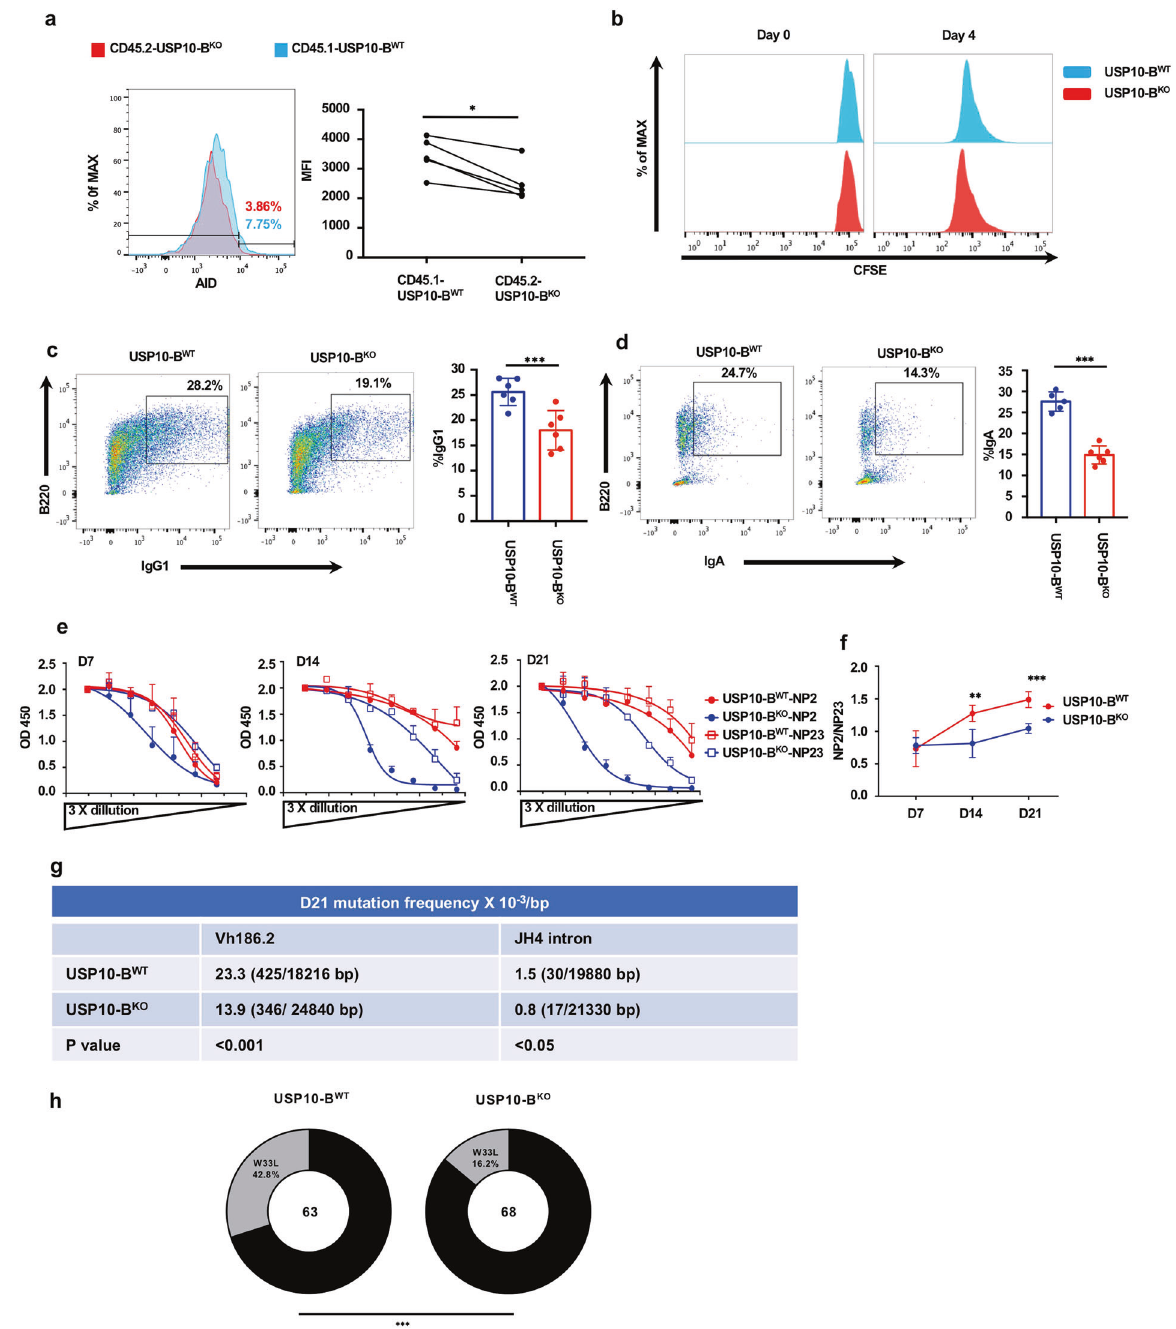
Fig. 3 The mice with USP10 knockout in B cells exhibited a low abundance of AID, impaired class switching, somatic hypermutation, and af fi nity maturation. a Representative fl ow cytometry of AID protein levels in germinal center B cells (B220 + GL7 + CD95 + ) in 50:50 mixed bone marrow (BM) chimera mice using CD45.1-USP10-B WT and CD45.2-USP10-B KO ( n = 5). b Cell proliferation was assessed by staining cells with CFSE. c , d Representative fl ow cytometry of CSR to IgG1 ( C ), IgA ( D ) in splenic naïve B cells in USP10-B WT or USP10-B KO mice. e – g USP10-B WT or USP10-B KO mice were immunized with NP-CGG and analyzed at the time indicated. e , f NP2 and NP23 binding antibodies (total Ig) in sera of immunized mice were analyzed by ELISA. e OD values versus dilution factors are plotted. f Ratios of NP2/NP23 were calculated with raw OD value in a linear range. g The sorted GC B cells pooled from four mice of each genotype were used for the genomic DNA extraction and sequencing of the VH186.2 exon and JH4 intronic region. The total mutation frequencies are shown. The statistical analysis was performed with Fisher ’ s exact test. h The frequency of W33L mutation in the VH186.2 heavy chain was determined by sequencing. The total numbers of clones sequenced are indicated at the center of the pies. Statistical analysis was done with Fisher ’ s exact test. Data were representative of multiple experiments. * P < 0.05, ** P < 0.01, *** P < 0.001